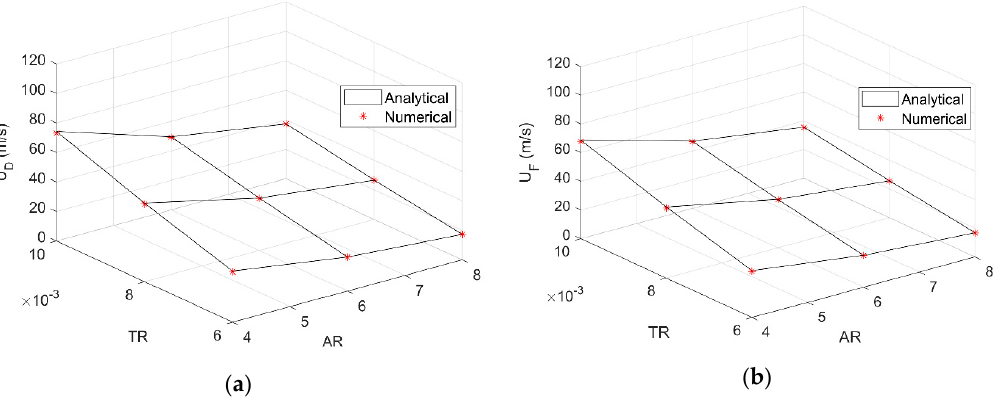
Figure 7. Divergence ( a ) and flutter ( b ) speeds according to SST.